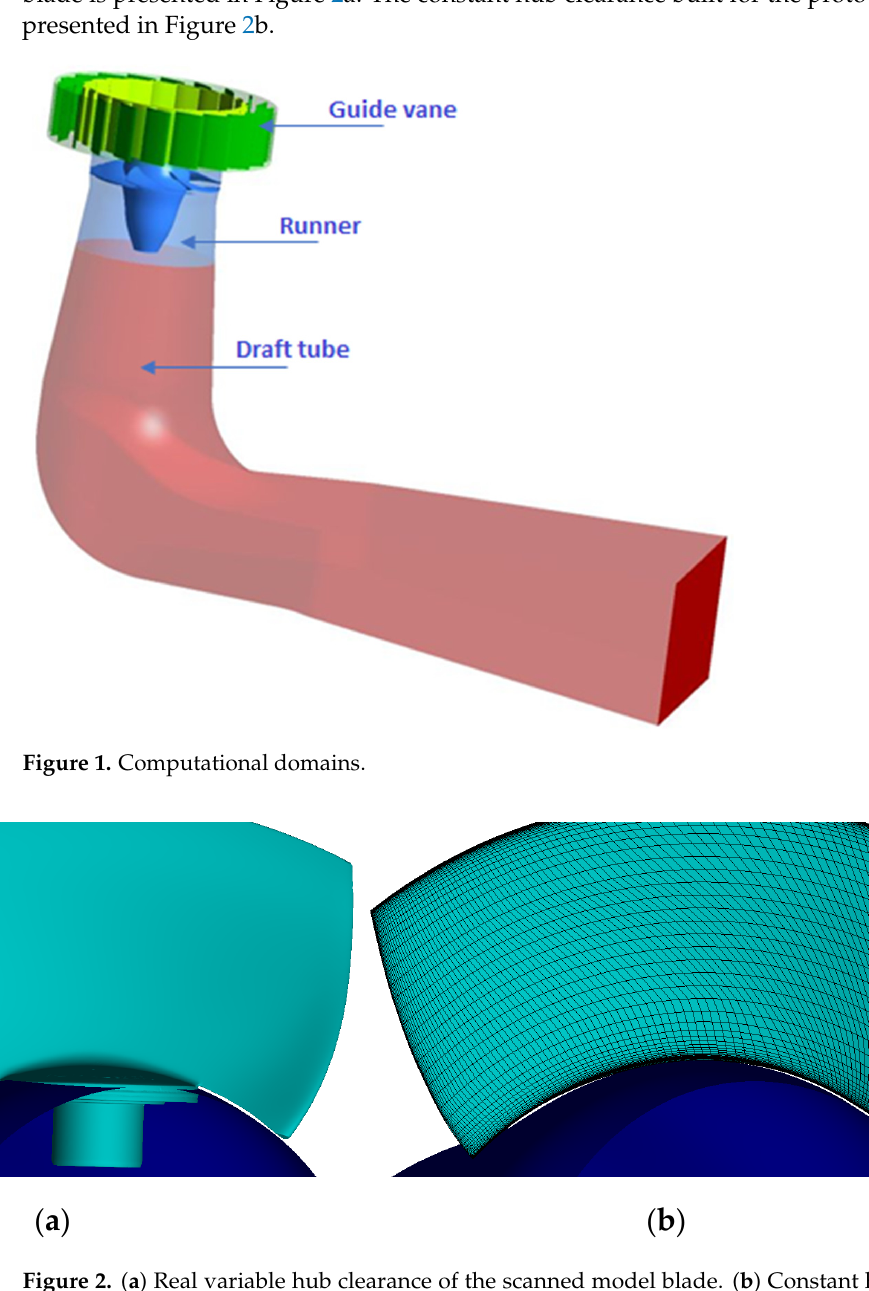
Figure 3. Runner and monitor points on the blade pressure side. 3.2. Mesh Hexahedral meshes were designed in ICEM v16.2 to discretize the guide vanes and draft tube domains. The hexahedral runner mesh was generated in Turbogrid v16.2, with the software optimized for blade passage discretization. Hexahedral elements are recommended as they can be better aligned to capture flow features and provide more accurate numerical results than tetrahedral elements. Additionally, the mesh size is considerably reduced when using hexahedral elements, a factor of 4 to 8 for a similar result, and consequently, the computational time is shorter. The refinement of the spatial discretization was chosen according to the mesh sensitivity studies carried out previously [19,21,22]. The numerical error was computed using the Richardson extrapolation. The influence of the runner mesh size on the torque value was less than 1%, while the draft tube discretization led to a 5% numerical error. The mesh quality parameters evaluated in Ansys CFX Solver are presented in Table 2 for each computational domain.